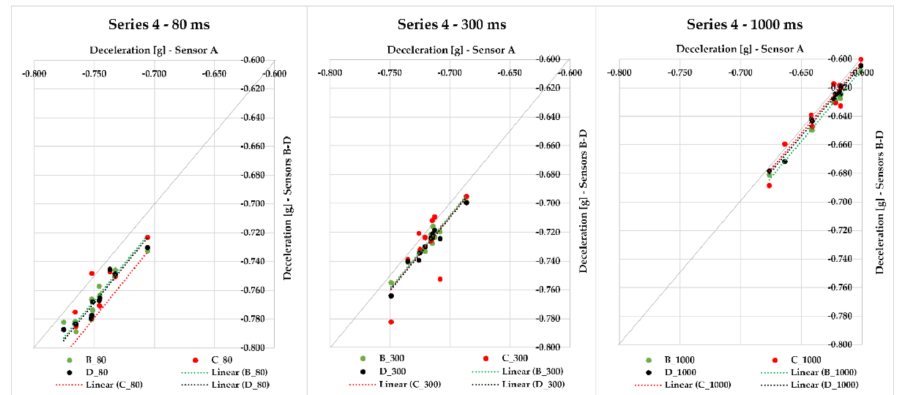
Figure 10. Series 4-Point dependency of individual MEMS sensors against sensor A.